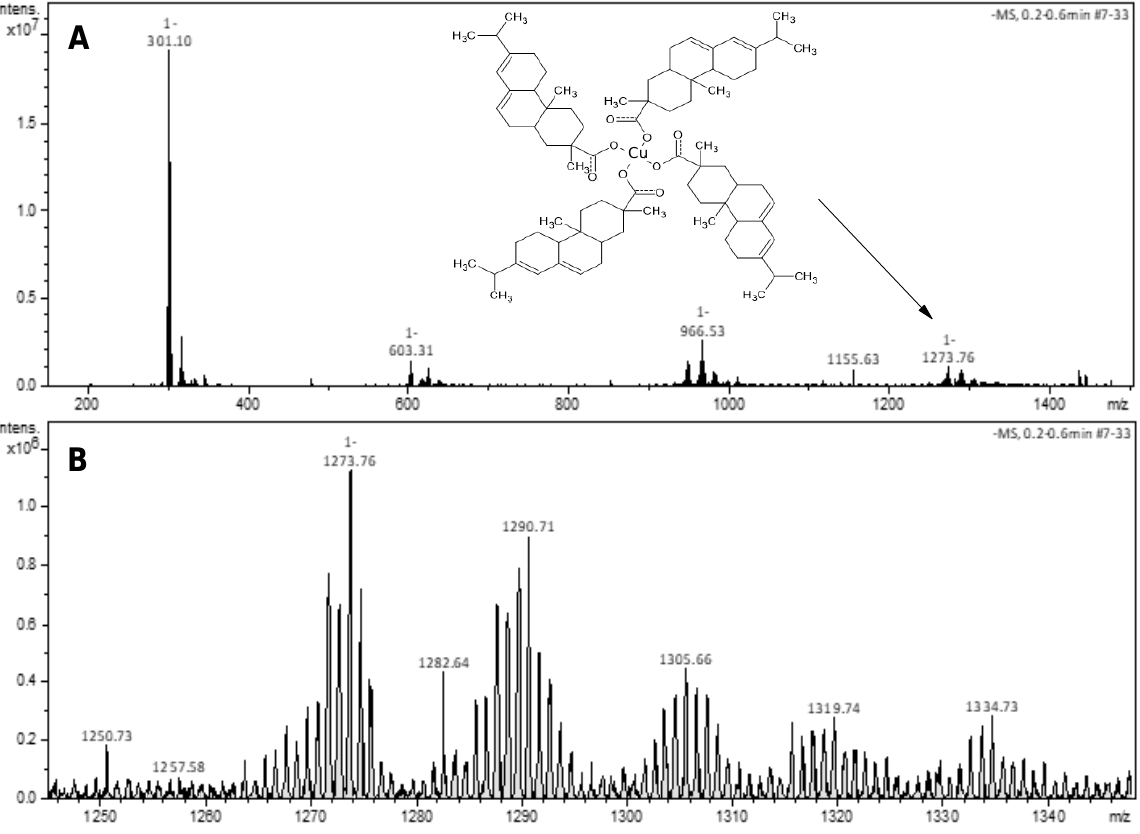
Figure 3. Mass spectra of the Cu-abietate. ( A ) The peaks corresponding to the molecular mass of deprotonated abietic acid (C 20 H 29 O 2 ) − ; to the dimeric form of abietic acid; the molecular mass of copper bound to three abietate ligands [Cu(C 20 H 29 O 2 ) 3 ] − ; and to the Cu-abietate complex constituted by four ligands (C 20 H 29 O 2 ) − , at corresponds to m / z − 301, m / z − 603, m / z − 966, and m / z − 1273, respectively. ( B ) Progressive oxidations of C=C bonds of the abietate ligand to the respective keto form, evidenced by the m / z difference of 16 units between the peaks.